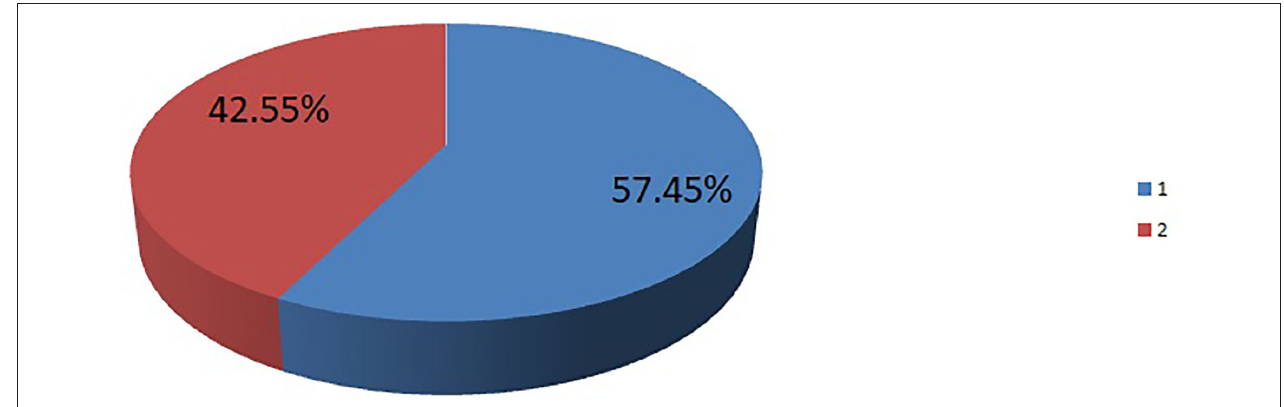
FIGURE 1 | The prevalence of pregnant women desired for birth companionship in Debremarkos city, northwest